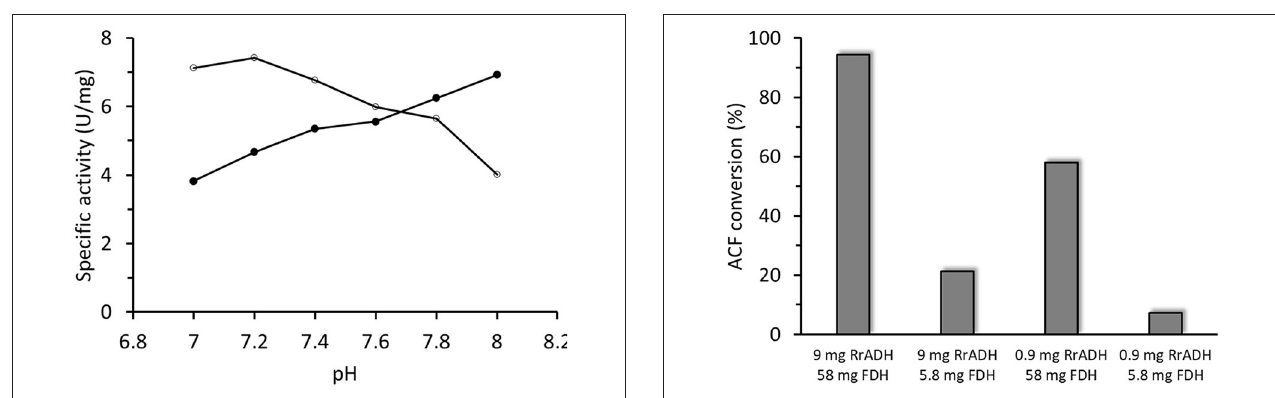
FIGURE 4 | pH-activity profile of recombinant alcohol dehydrogenase from Rhodococcus ruber determined for isopropanol oxidation ( • ) and acetone reduction ( ◦ ).